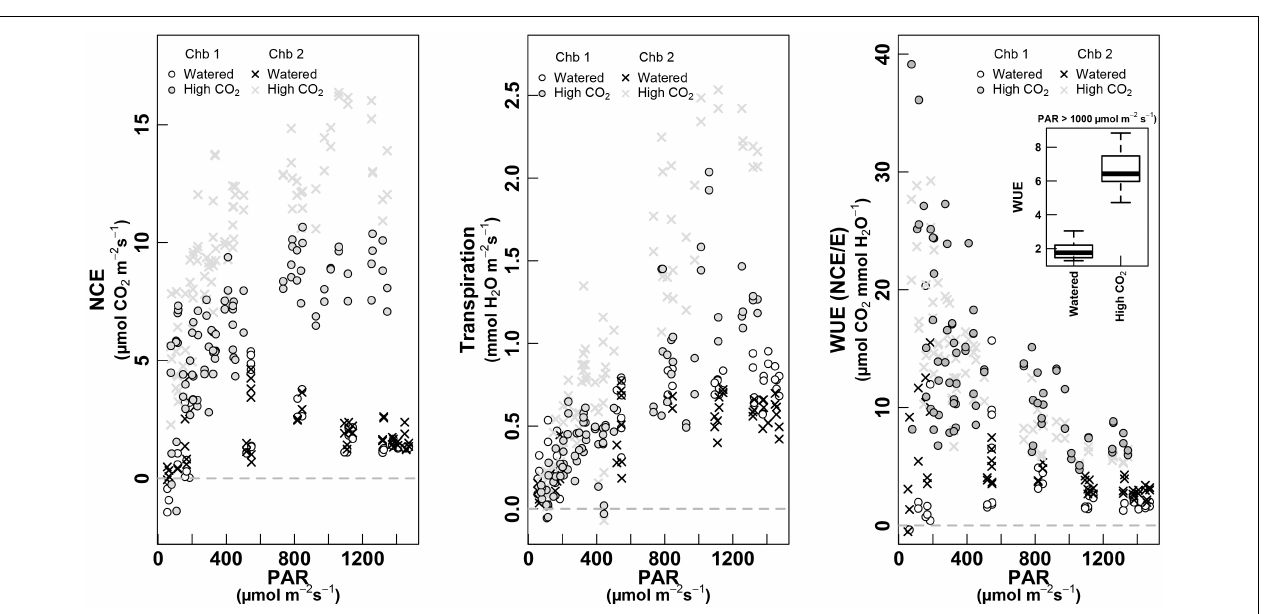
FIGURE 8 | PAR response curves for NCE—whole-plant net carbon exchange (left, µ mol m − 2 s − 1 ), whole-plant Transpiration (mmol m − 2 s − 1 , middle) and WUE as NCE/E ( µ mol CO 2 mmol − 1 H 2 O, right). The relationship is shown for the two treatments: white dots for “Watered” of chamber 1 and crosses for chamber 2; gray dots for “High CO 2 ” for chamber 1 and gray crosses for the chamber 2 (both treatments were measured in September 2017, on the same plant). The boxplot inset in the right panel shows values of WUE for each treatment when PAR is > 1,000 µ mol m − 2 s − 1 . Only data with PAR > 50 µ mol m − 2 s − 1 are